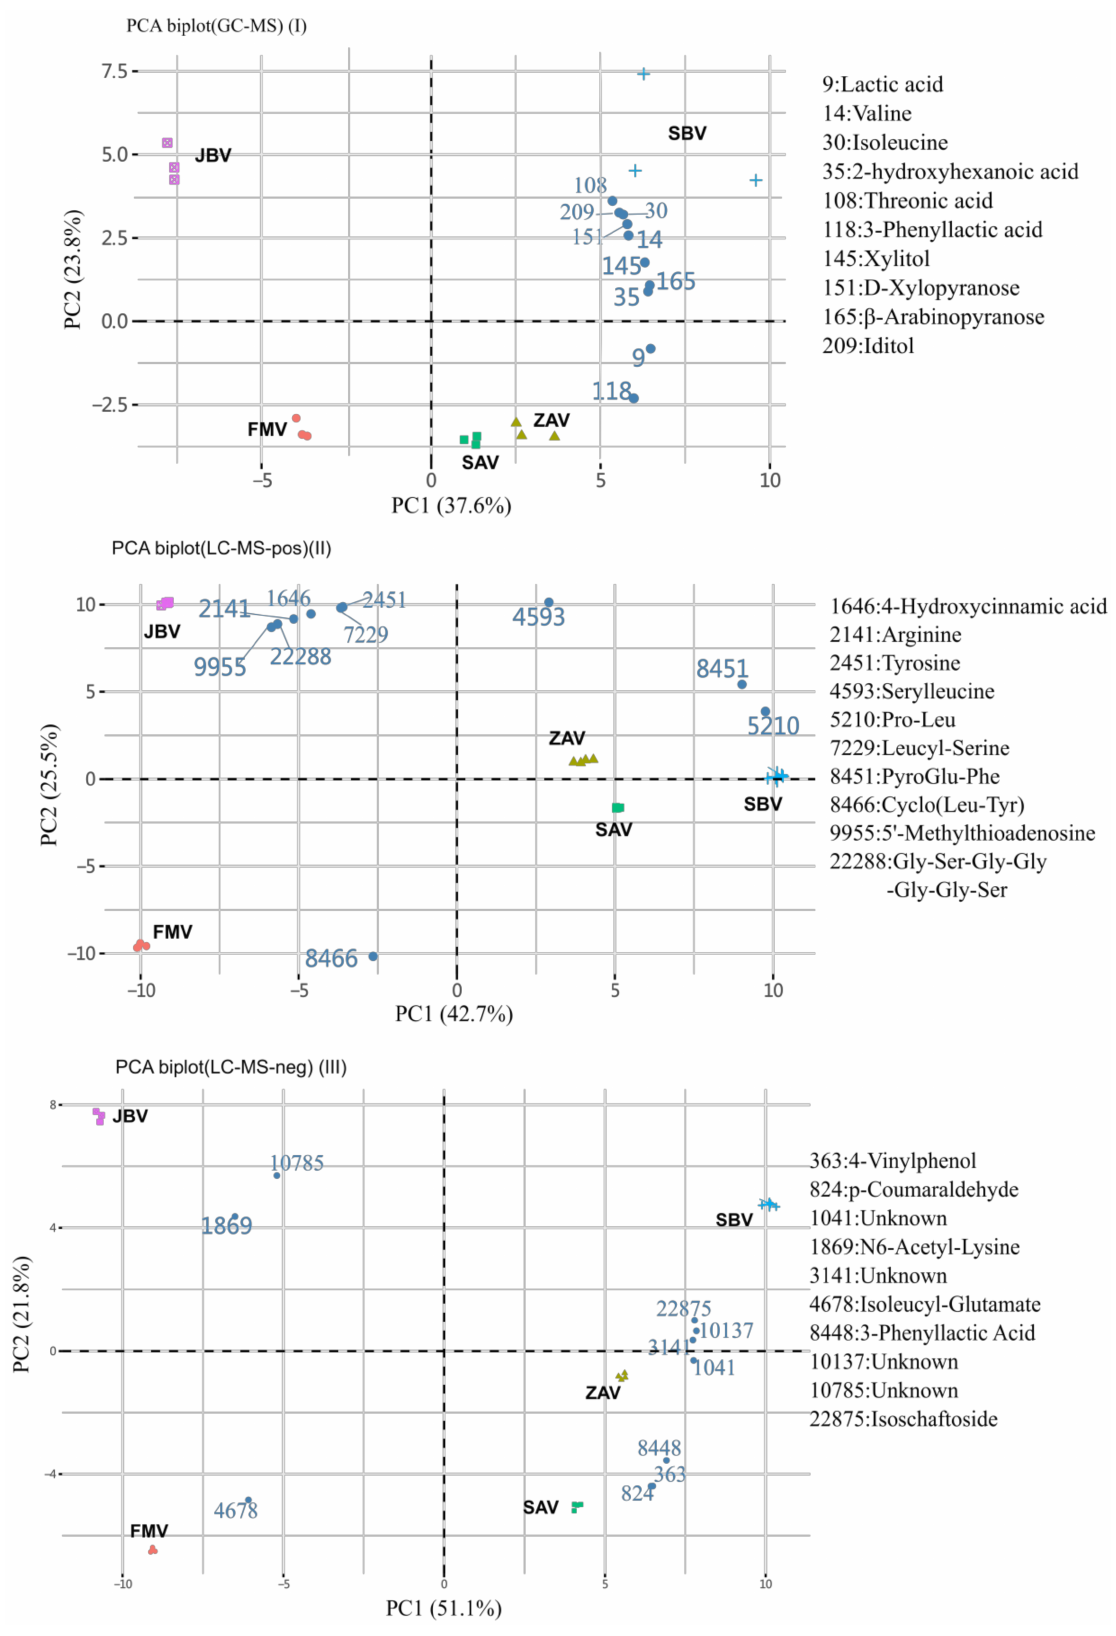
Figure 2. PCA biplots of vinegar metabolites based on non-targeted metabolic